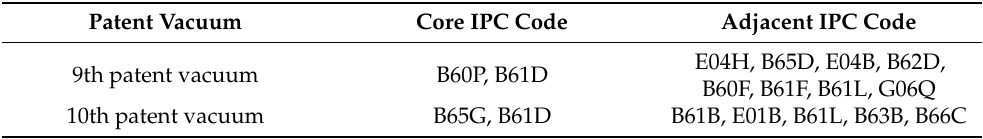
Table 8. IPC codes to investigate for patent vacuum